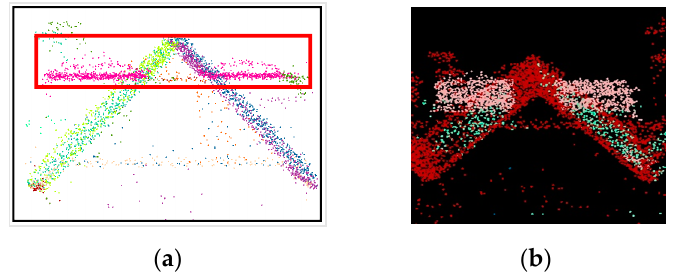
Figure 6. ( a ) The two dormers in the red rectangle belong to the same planar segment and therefore need connected components analysis to separate them (different colors indicate different segments); ( b ) Both changes to roofs and dormers are detected (two data epochs are merged). Table 2. Parameters for deciding on change.